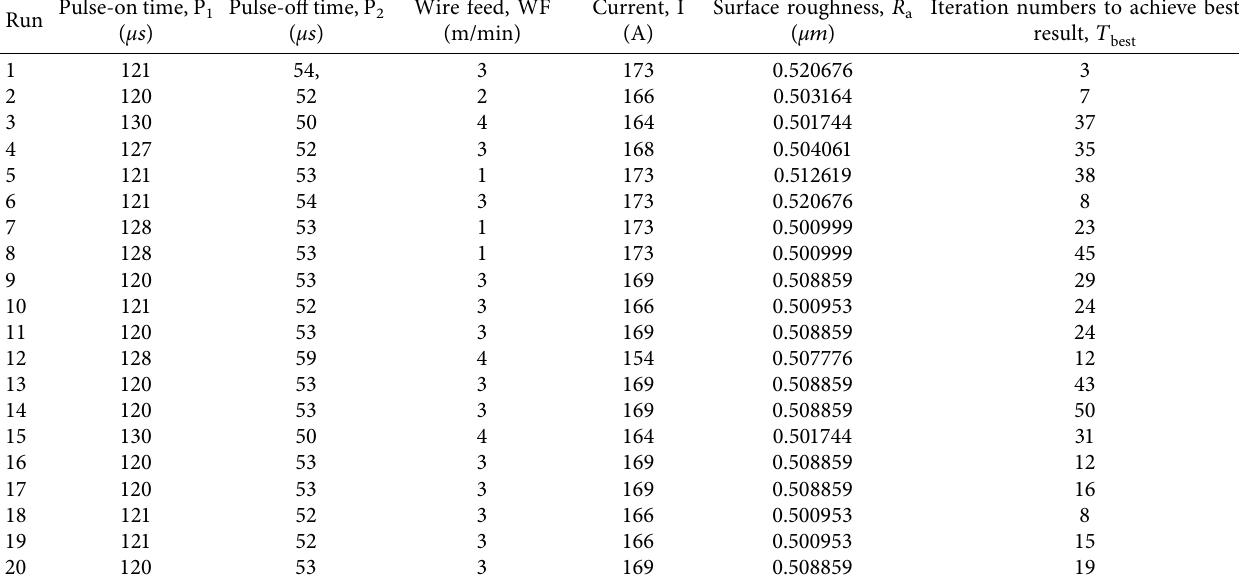
Table 9: Optimal machining parameters and the corresponding response variables produced by GTO in 20 consecutive simulation runs. Pulse-on time, P 1 Run ( μ s